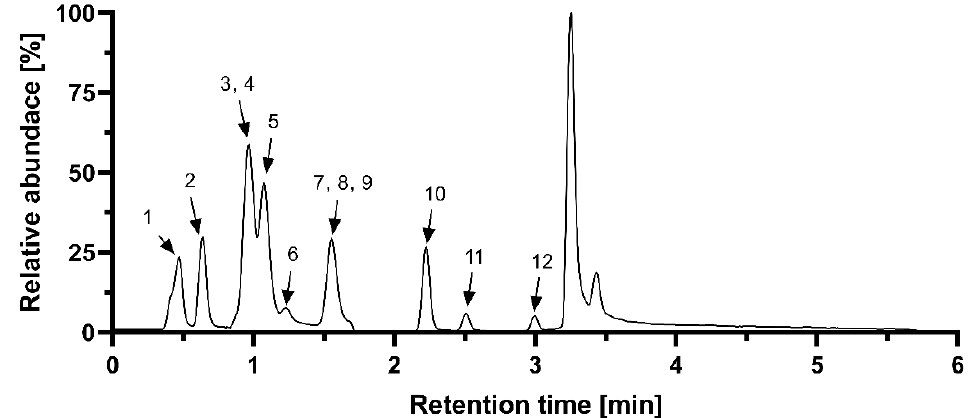
Figure 2. Representative chromatogram of measured phenolic acids. 1. gallic acid; 2. protocatechuic acid; 3. chlorogenic acid; 4. salicylic acid; 5. p -hydroxycbenzoic acid; 6. vanillic acid; 7. caffeic acid; 8. syringic acid; 9. benzoic acid; 10. p -coumaric acid; 11. ferulic acid; 12. cinnamic acid.